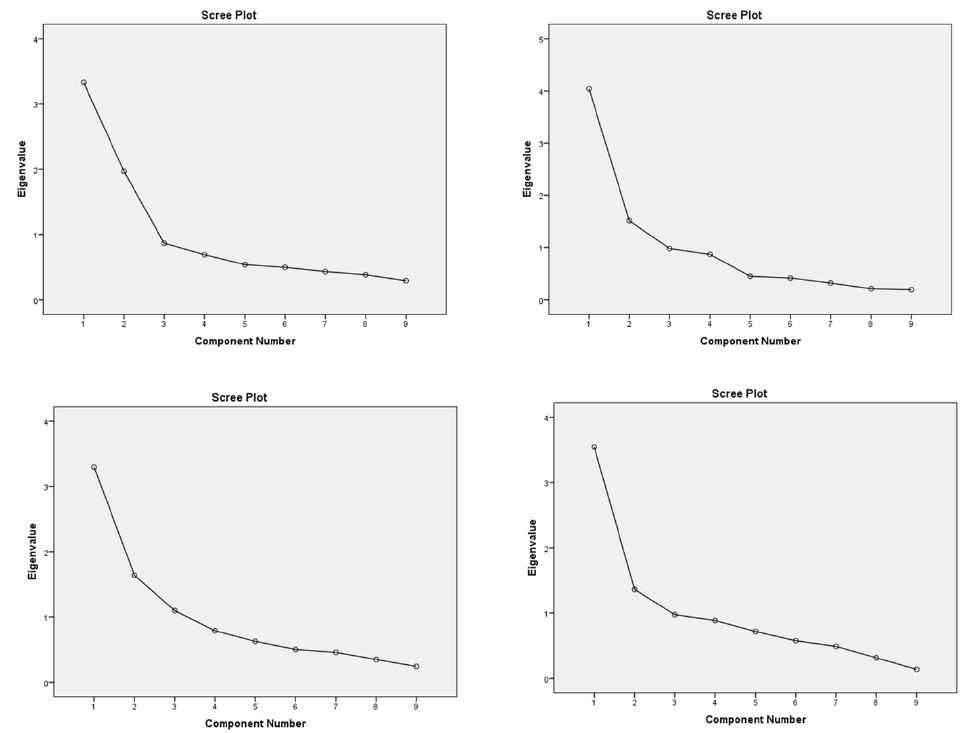
Figure 7. Cattell diagram of components and eigenvalues for the social field.